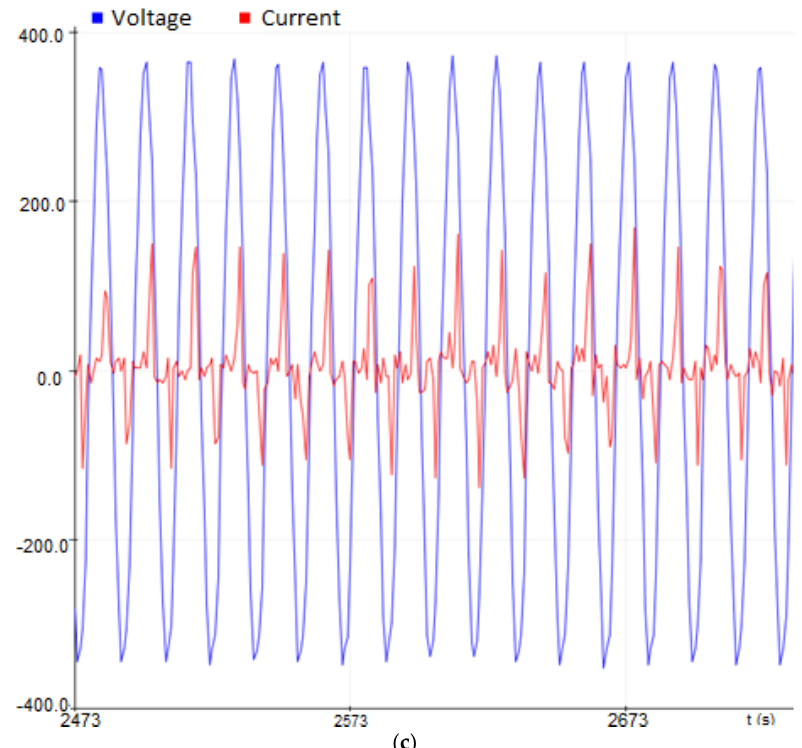
Figure 15. Voltage and current of three different loads: an ( a ) incandescent lamp, ( b ) electric iron box, and ( c ) laptop charger.